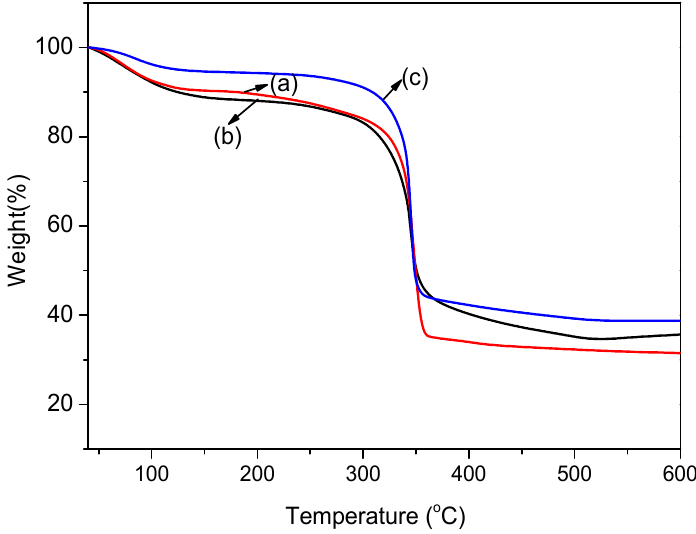
Figure 4. Thermogravimetric analysis (TGA) curves of ( a ) Cu-BTC, ( b ) NH 2 -Cu-BTC and ( c ) sub-NH 2 - Cu-BTC.